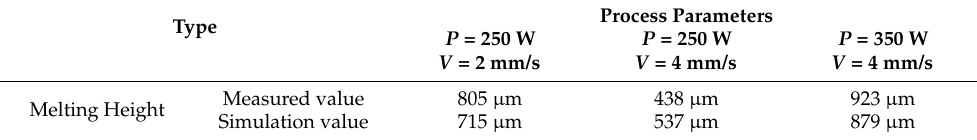
Table 5. Comparison of the measured and simulated values of the melting height.